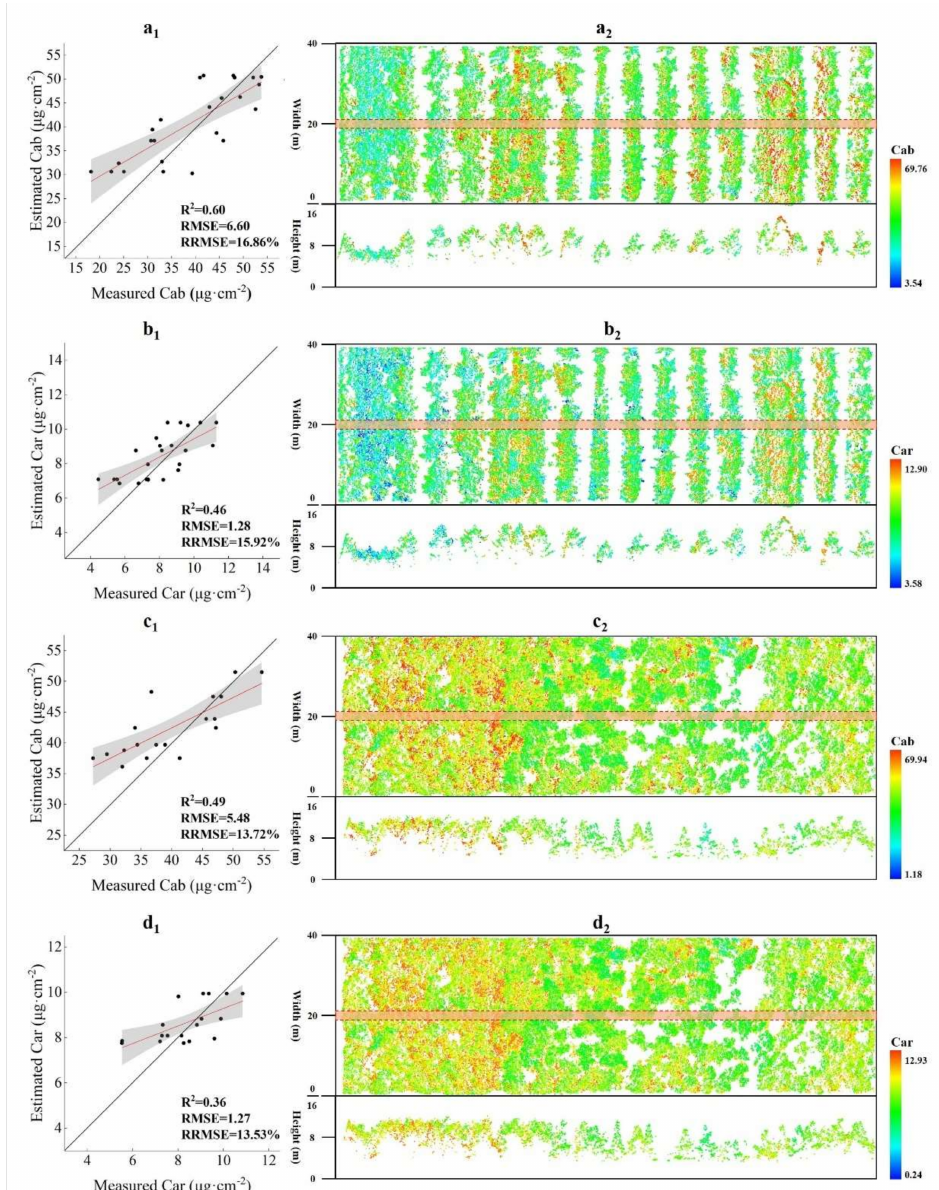
Figure 8. Horizontal and vertical estimation distribution of pigments content at different ages based on the best LUT by point-based hyperspectral data. ( a ): Cab estimation results of the 13-year-old plot ( µ g · cm − 2 ); ( b ): Car estimation results of the 13-year-old plot ( µ g · cm − 2 ); ( c ): Cab estimation results of the 13-year-old plot ( µ g · cm − 2 ); ( d ): Car estimation results of the 13-year-old plot ( µ g · cm − 2 ); ( a 1 – d 1 ): the corresponding optimal inversion models; ( a 2 – d 2 ): represent the horizontal and the vertical (from top to bottom in each figure) estimation distribution of pigment content (the orange cross-section was segmented to show the vertical